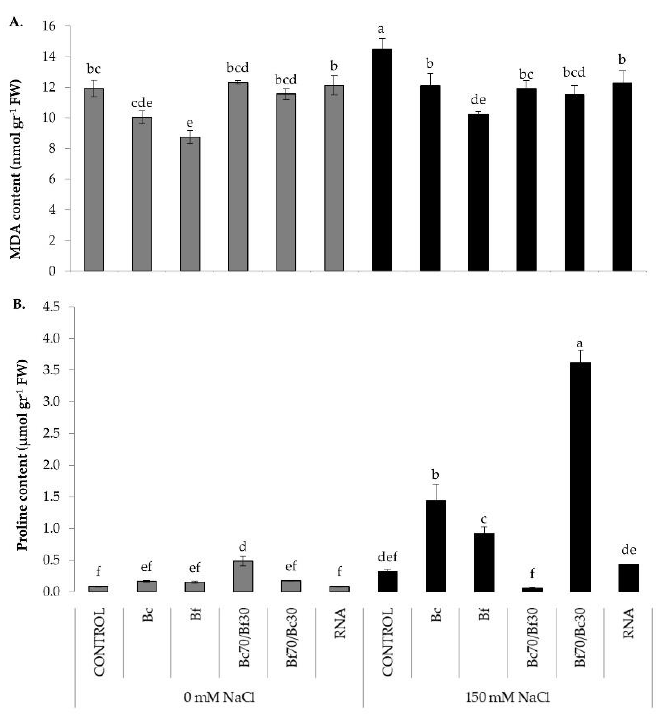
Figure 3. Effect of biostimulant treatments on osmoprotectant and cellular damage indicators production in control (0 mM) and salt-stressed (150 mM) conditions. ( A ) Proline quantification, ( B ) MDA quantification. Data are means ± SE of three replications. Bars with different letters are significantly different ( p < 0.05). Treatment abbreviations are explained in Figure 1.